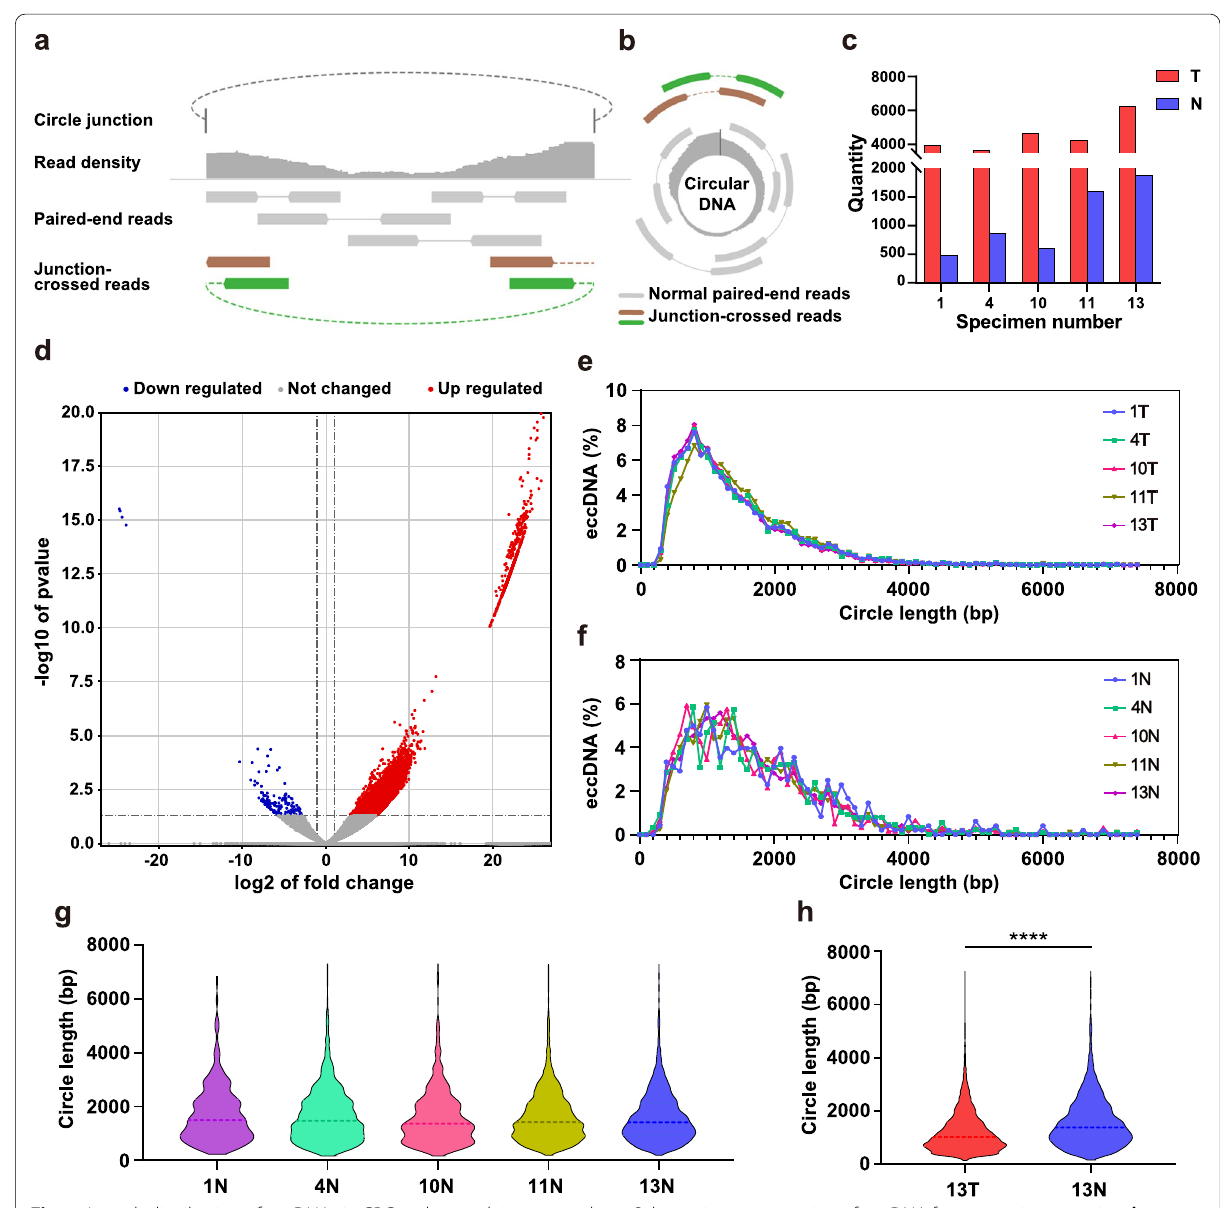
Fig. 1 Length distribution of eccDNAs in CRC and normal tissue samples. a Schematic representation of eccDNA fragmentation mapping. b Schematic representation of circularization of tiled eccDNA. c Histogram of the quantity of eccDNA in each tumor group and normal group. Y-axis does not omit the intervals, only the percentages of 0–500 is increased to visualize the data in normal group. d Volcano plot for the comparison between the eccDNAs in tumor group and normal group. The cutoff values fold change > 2 and P value < 0.05 were utilized to identify differentially expressed genes. e - f Line chart of the percentage of length distribution of eccDNA in each tumor group and N. g Violin plots of the length distribution of eccDNA in 13 T and 13 N ( n 6058 in 13 T, n 294 in 13 N, P < 0.0001). h Violin plots of the length distribution of eccDNA in each = = normal group. The dashed line is the median of each